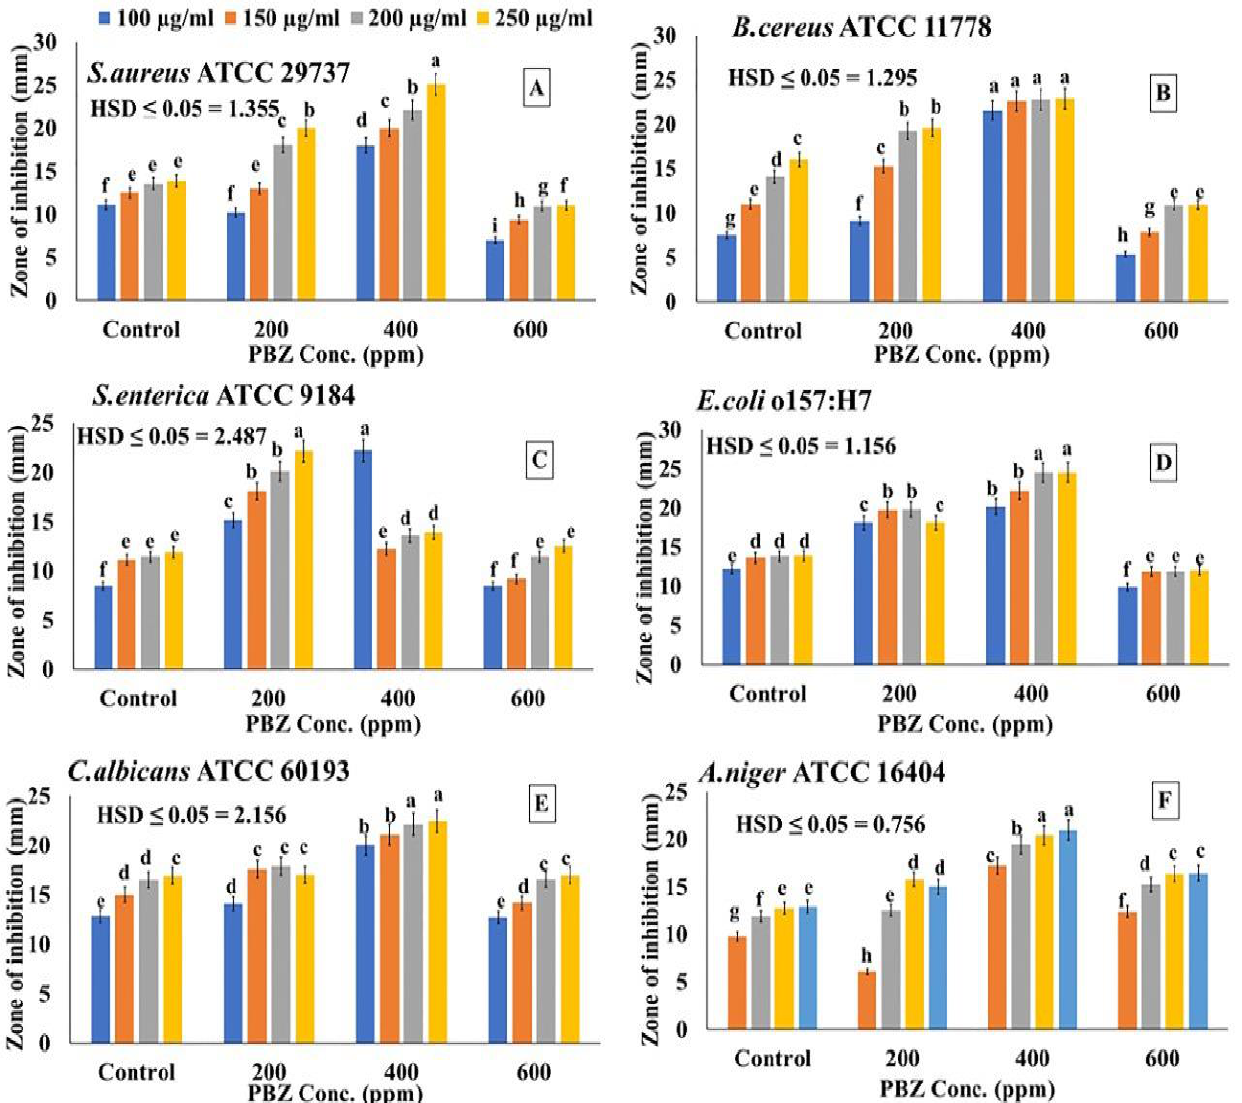
Figure 6. The antibacterial and antifungal activities of the essential oil extracted from lavender ( Lavender officinalis ) plants, treated by paclobutrazole (PBZ) at 0, 200, 400, and 600 ppm, against S. aureus ( A ), B. cereus ( B ), S. enterica ( C ), E. coli ( D ), C. albicans ( E ), and A. niger ( F ). Values are the averages of 3 replicates ± SD. Different letters indicate significant differences, according to Tukey’s Studentized Range (HSD) Test ( p < 0.05).